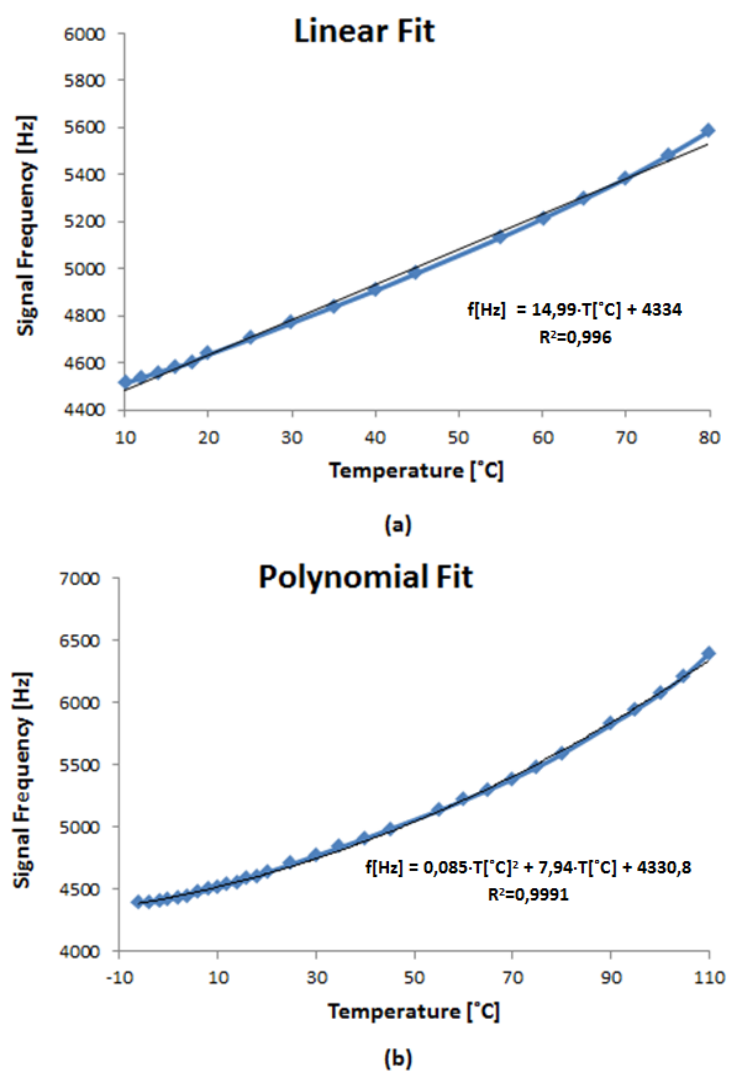
Figure 9. ( a ) T-f response curve with a linear fit. ( b ) T-f response curve with a second order polynomial